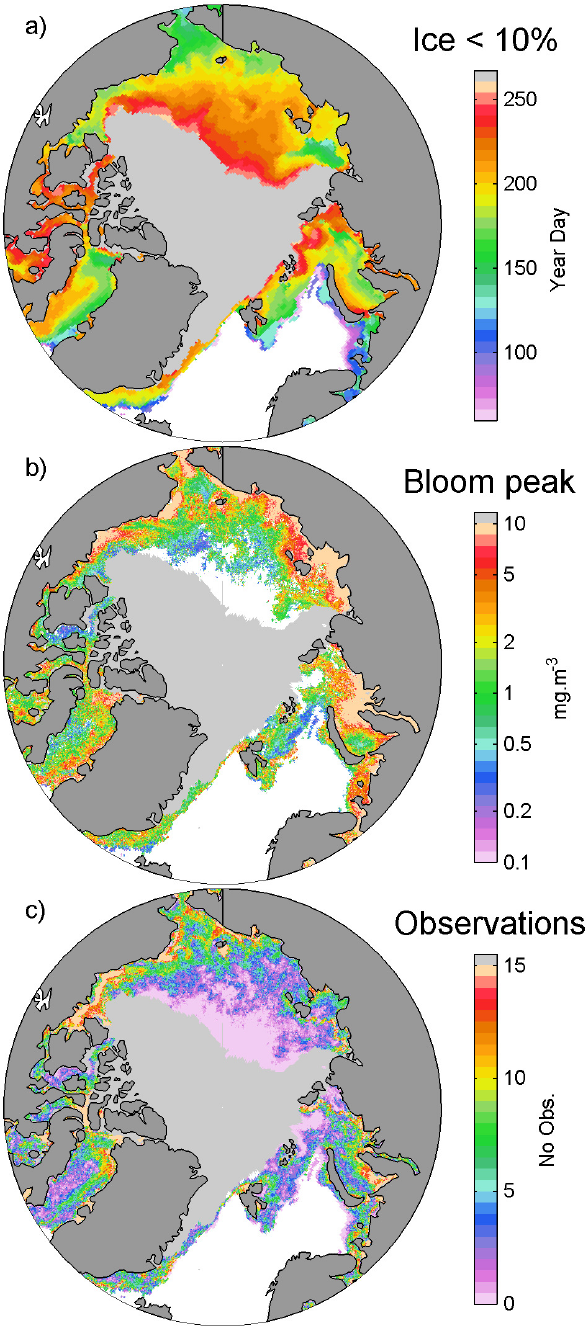
Fig. 4. Summary statistics for whole Arctic during 2007. The land mask is shown in dark grey, light grey areas correspond to per- manent sea-ice cover, and white areas to open-ocean or missing data. (a) First day of the year that is durably ice-free. (b) Max- imum chlorophyll concentration attained within the moving